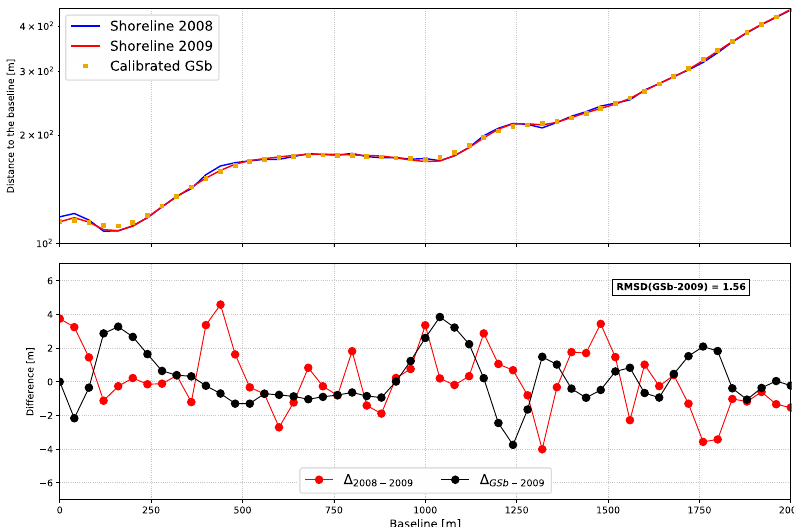
Figure 5. Top: historical shorelines adopted for the calibration of the General Shoreline beach (GSb) model; bottom: distribution of the difference between the 2009 shoreline and the GSb model output (with K GSb = 0.3) and the di ff erence of the two 2008 and 2009 Google Earth shorelines.